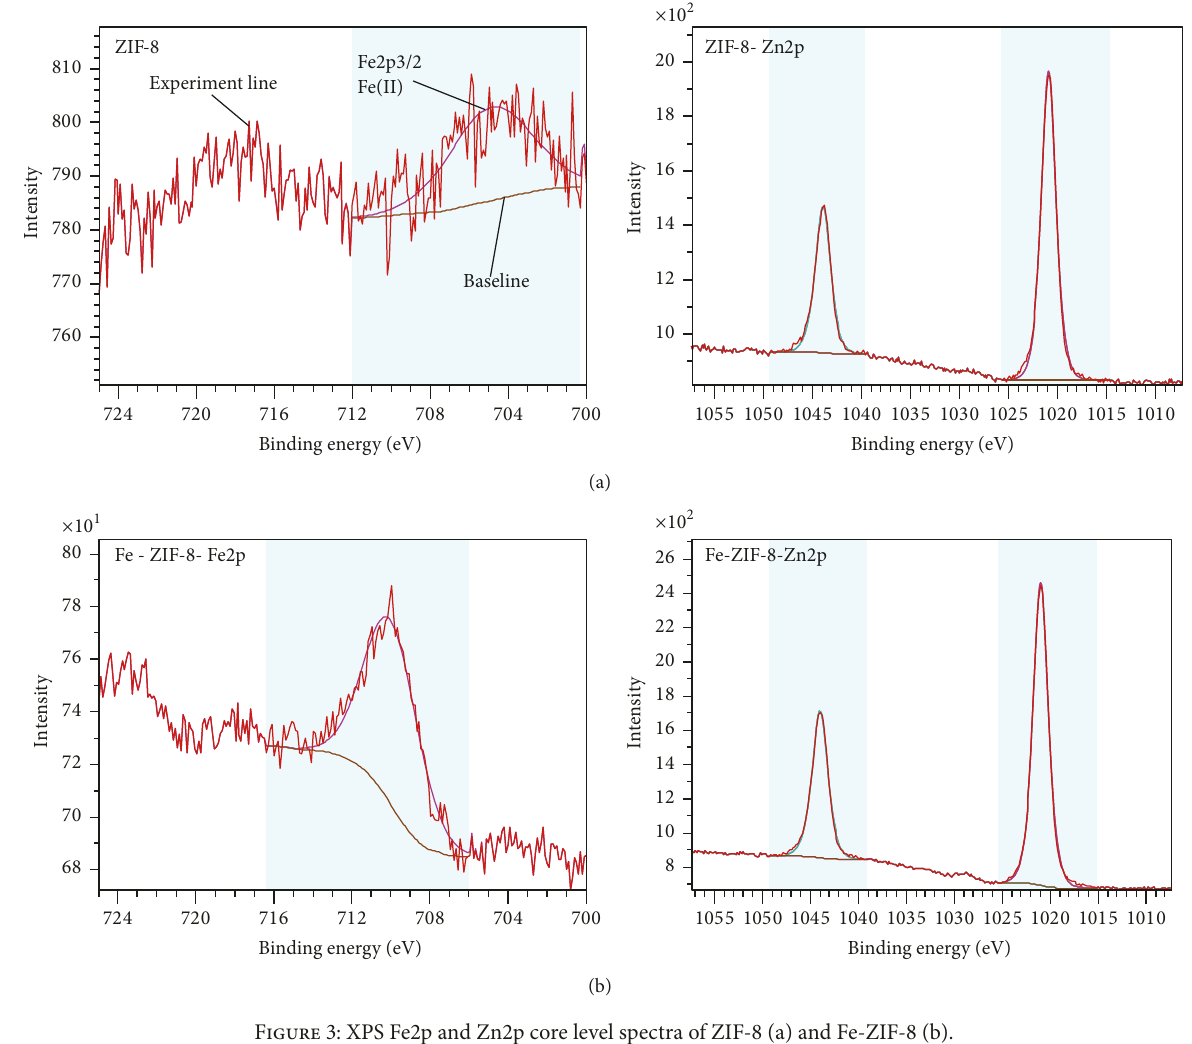
Figure 3: XPS Fe2p and Zn2p core level spectra of ZIF-8 (a) and Fe-ZIF-8 (b).